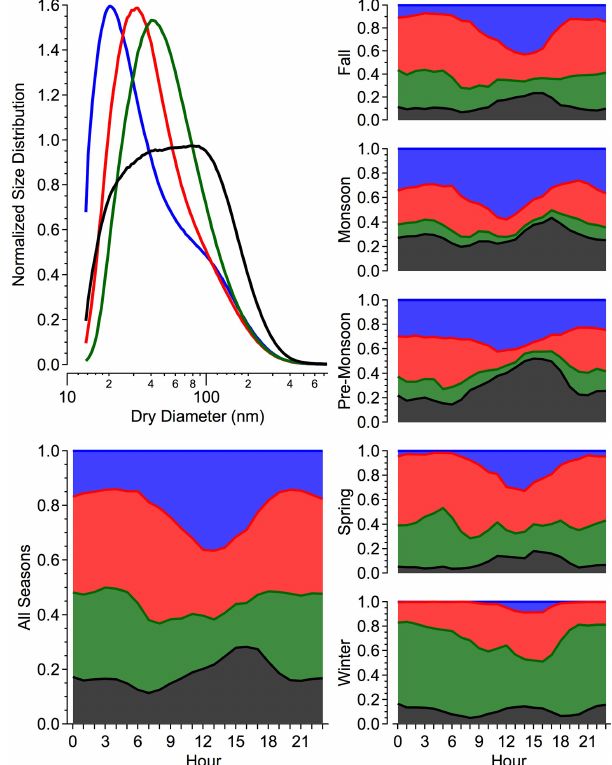
Figure 5. Size distribution cluster centroids, as derived by the “ K - means” algorithm, and the hourly distribution of cluster associa- tions, separated by season. Clusters are assigned the following iden- tifiers: nucleation (N; blue), fresh fossil (FF; red), winter/nocturnal (WN; green) and condensation/coagulation (CC;